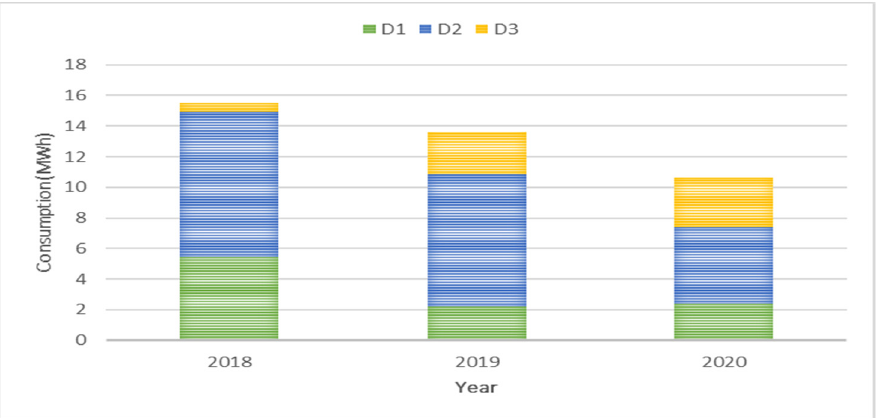
Figure 6. Load per substation for the years 2018–2020.